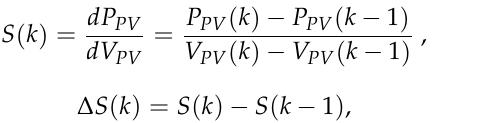
Figure 6. Fuzzy logic membership functions.